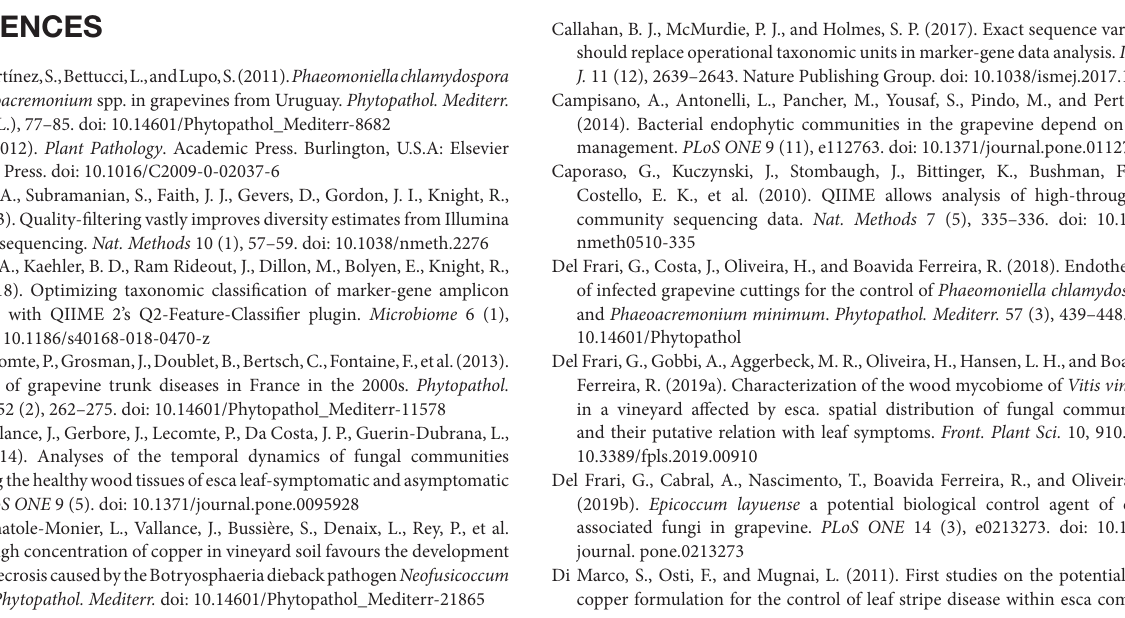
TABLE S1 | Fungal taxa identified to genus or species level in the wood of grapevine rooted cuttings, at relative abundances (RA) inferior to 0.1 % or 0.01% of the total.